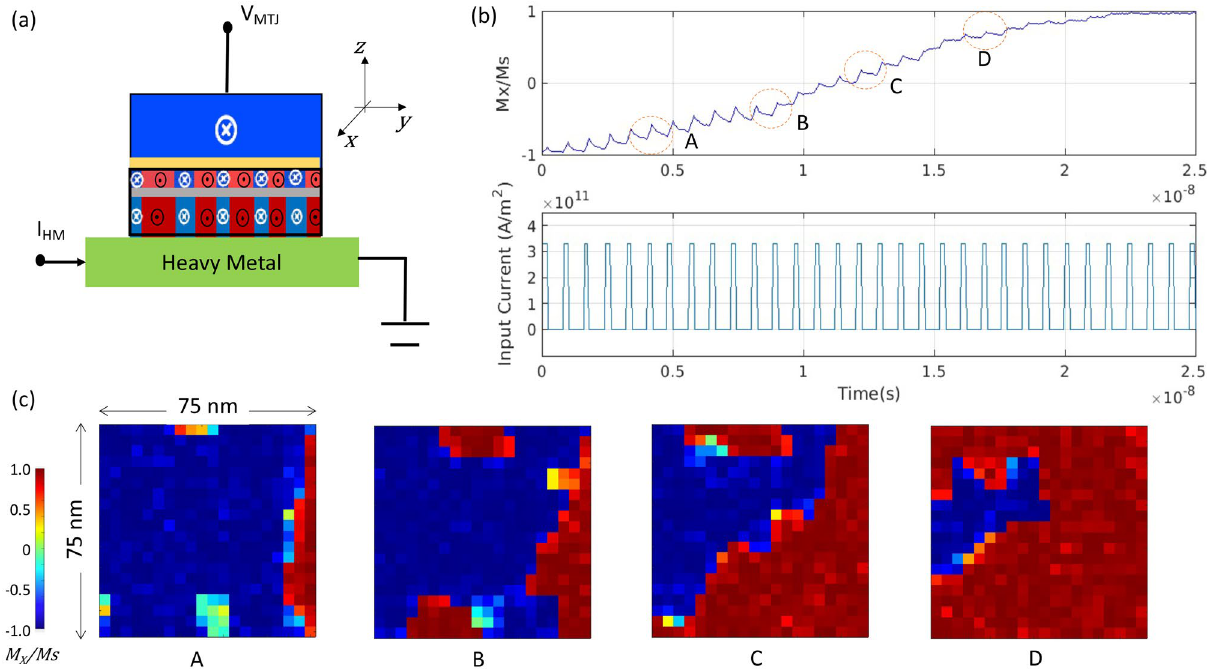
Figure 2. Mumax simulation of spin current driven multi-domain switching. ( a ) Device structure of a spin-orbit-torque driven MTJ with the exchange-coupled FL. ( b ) Evolution of the normalized M X dynamics under input spikes. The spikes have a magnitude of 3.3e11 A/m 2 with duration of 0.25 ns. ( c ) Snapshots of the magnetization during the progressive switching process. The transitions from blue to red represent the switching of local magnetic moments from M X /Ms = − 1 to M X /Ms =